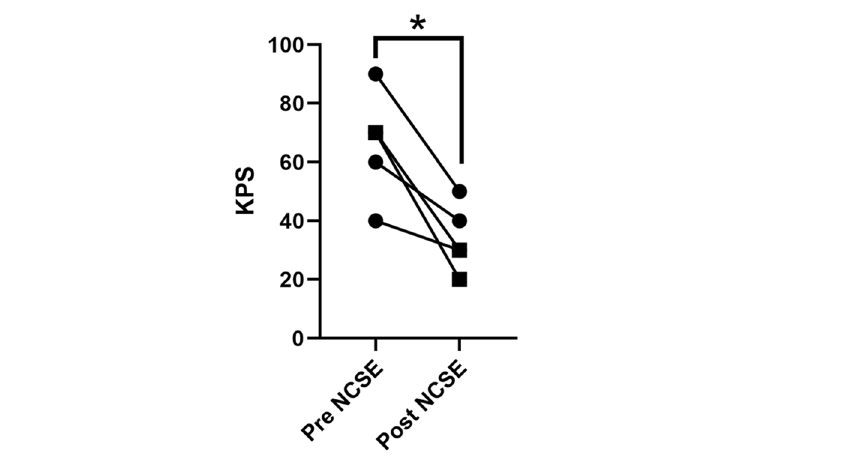
Fig. 1 KPS changes before and after NCSE. Pre KPS is prehospital KPS just before an NCSE episode. Post KPS is KPS at discharge from the hos- pitalization for NCSE. Prehospital mean KPS was 66, mean KPS at discharge was 34. The mean KPS scores were compared between Pre KPS